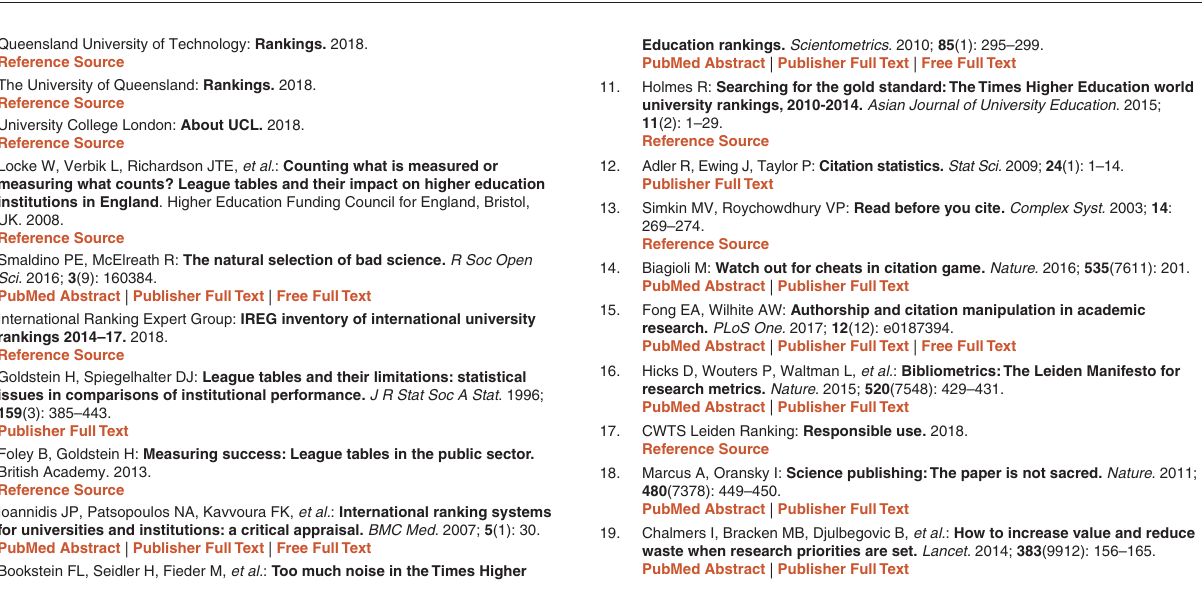
• Supplementary Table 3. Top 50 ranked universities in 2017. • Supplementary Figure 2. Scatter plot of the width of the 95% bootstrap interval against rank using the top 200 universities in both